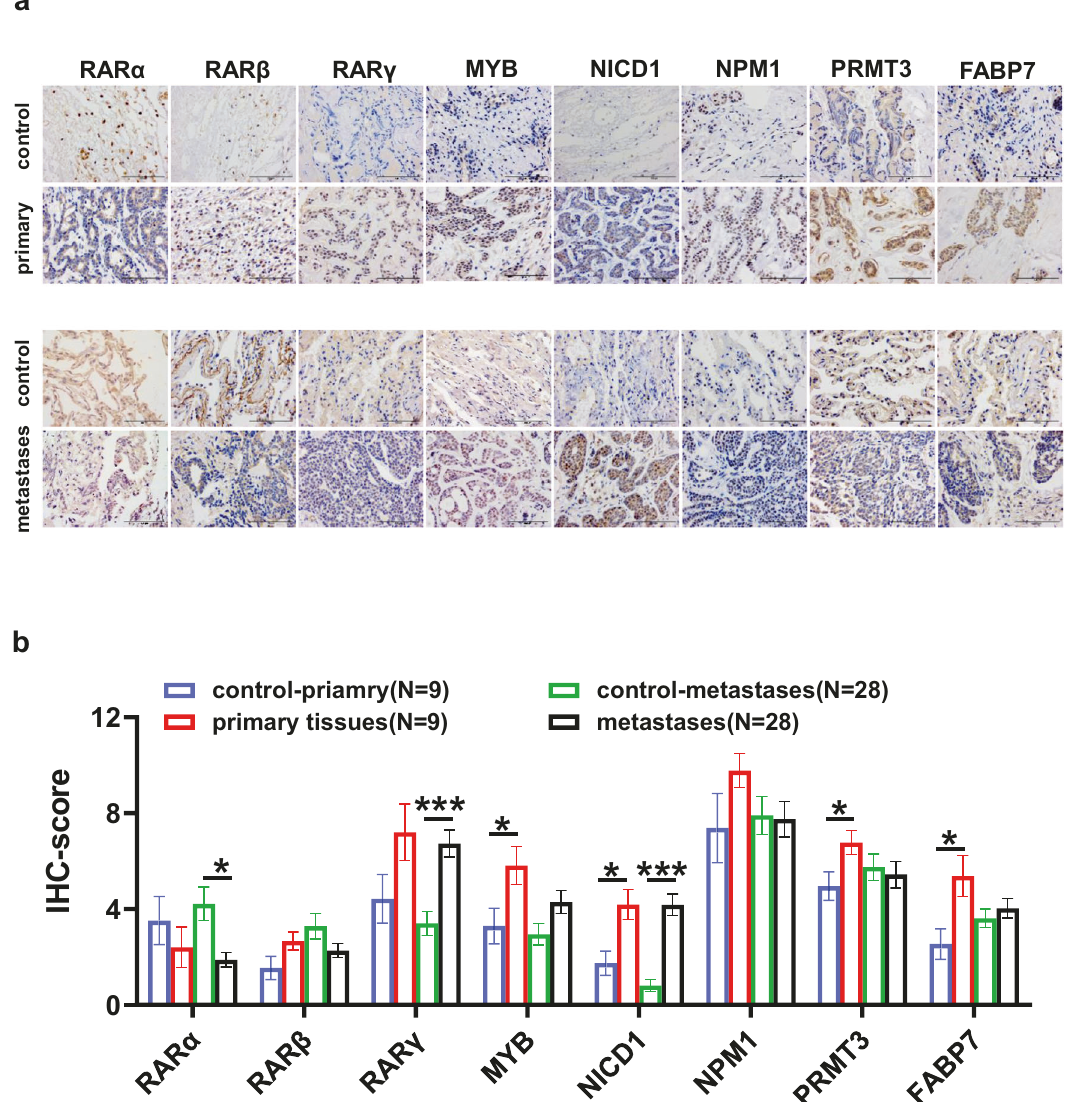
Fig. 8 RAR α shows signi fi cant downregulation in ACC metastatic lung tissues. a Representative images of MYB, NICD1, FABP7, NPM1, PRMT3, and RARs IHC in 28 ACC lung metastasis samples or nine primary tumor samples versus matched normal tissue samples and statistical analysis ( b ). The p values were calculated using the two-tailed Mann – Whitney U -test. Data were presented as the mean ± SEM. p < 0.05 (*), p < 0.01 (**), and p < 0.001 DATA AVAILABILITY All data supporting the fi ndings of this study are available from the corresponding author upon reasonable request.